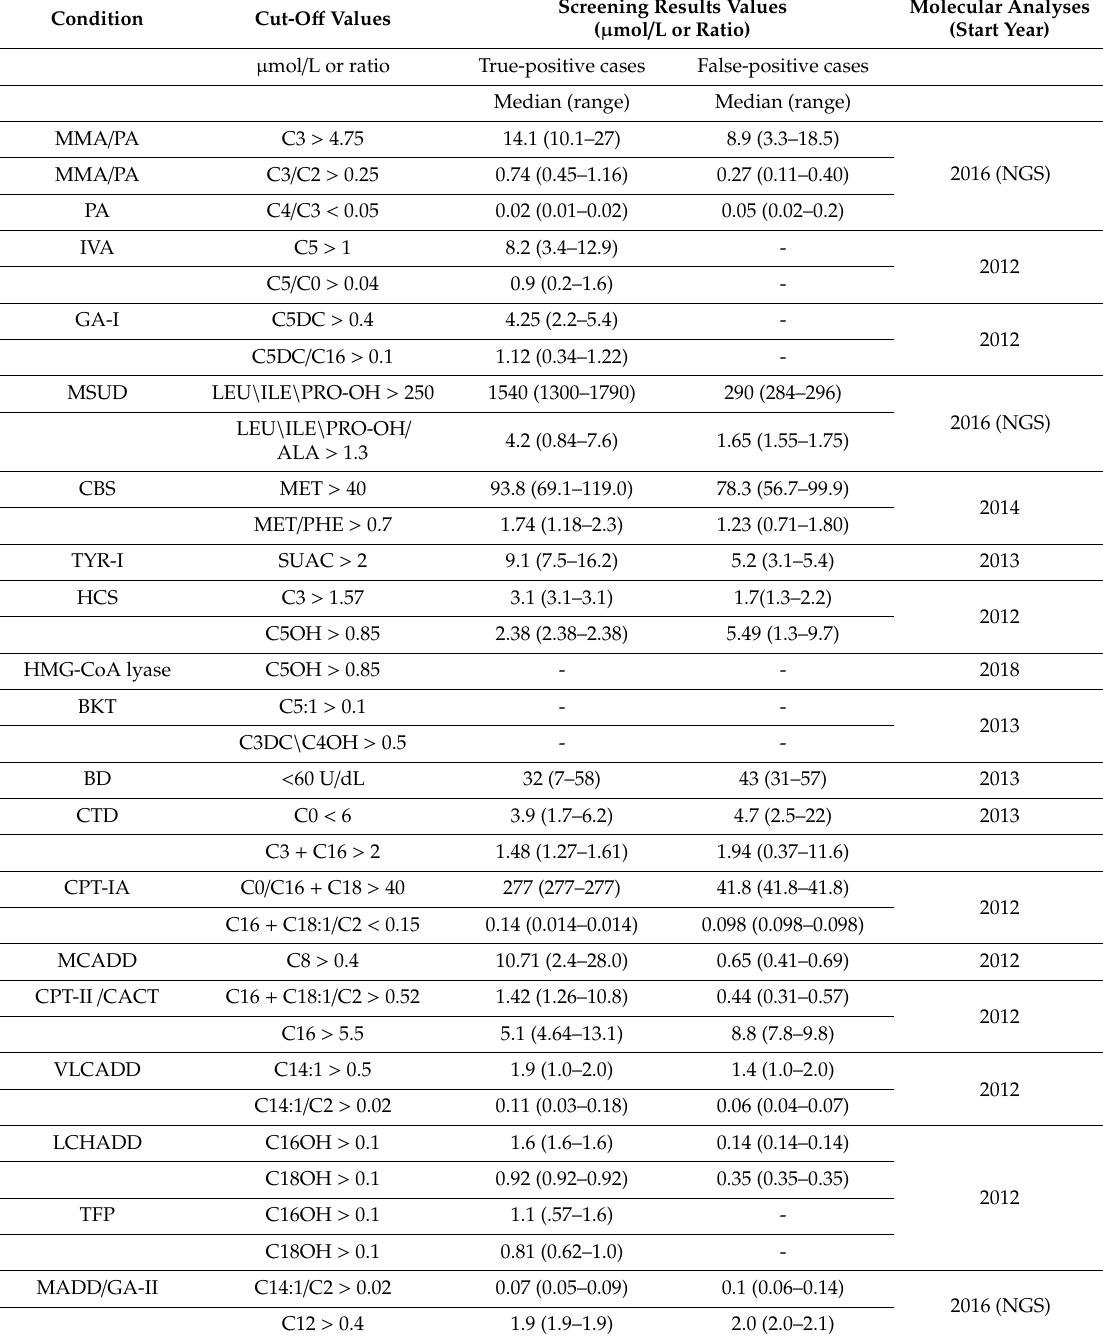
Table 1. Screening thresholds, results values and start years for dried blood spot (DBS) molecular analyses in true and false positives reported during expanded newborn screening (eNBS) for